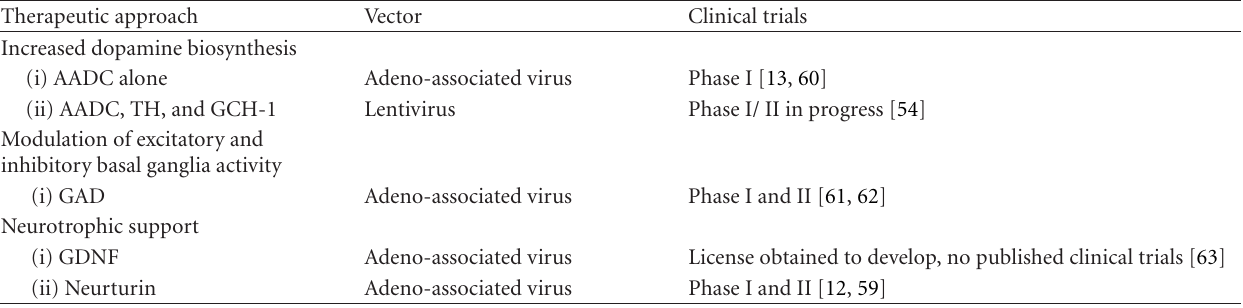
Table 1: An overview of the therapeutic approaches used in current clinical trials of gene therapy for Parkinson’s